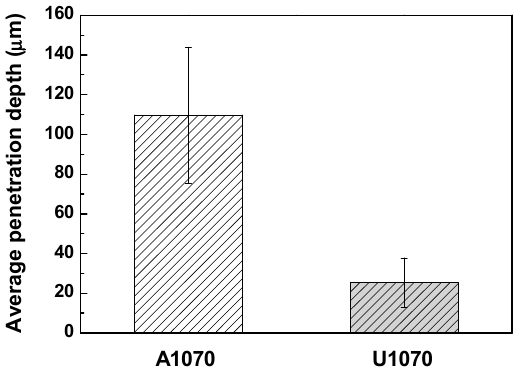
Figure 5. Average corrosion penetration depth of A1070 and U1070 specimens after polarization tests. Table 5. Parameters extracted from the polarization curves of A1070 and U1070.